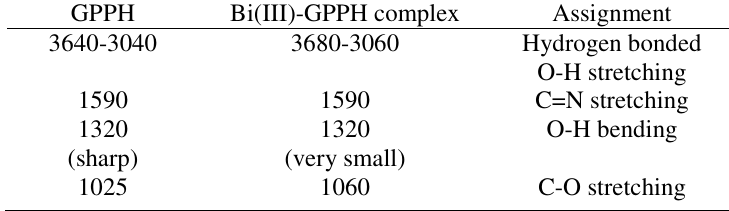
Table 4. Absorption frequencies (cm -1 ) of GPPH and its bismuth complex and their